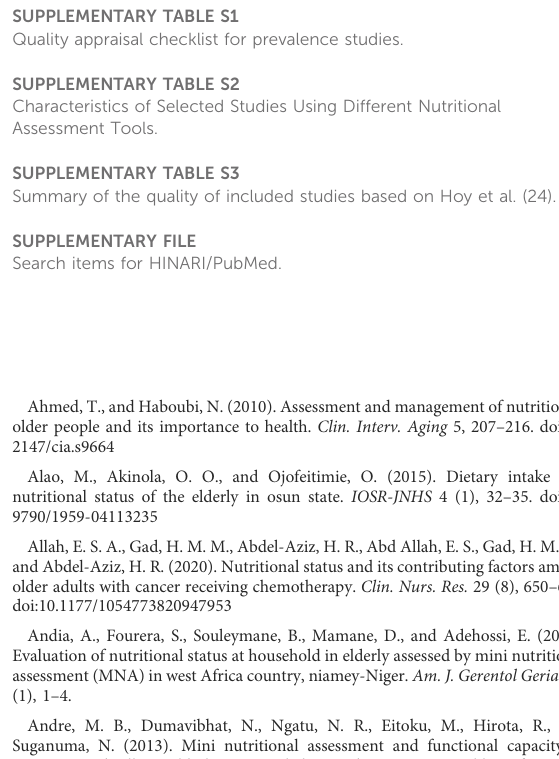
SUPPLEMENTARY TABLE S1 Quality appraisal checklist for prevalence studies. SUPPLEMENTARY TABLE S2 Characteristics of Selected Studies Using Different Nutritional Assessment Tools. SUPPLEMENTARY TABLE S3 Summary of the quality of included studies based on Hoy et al. (24). SUPPLEMENTARY FILE Search items for